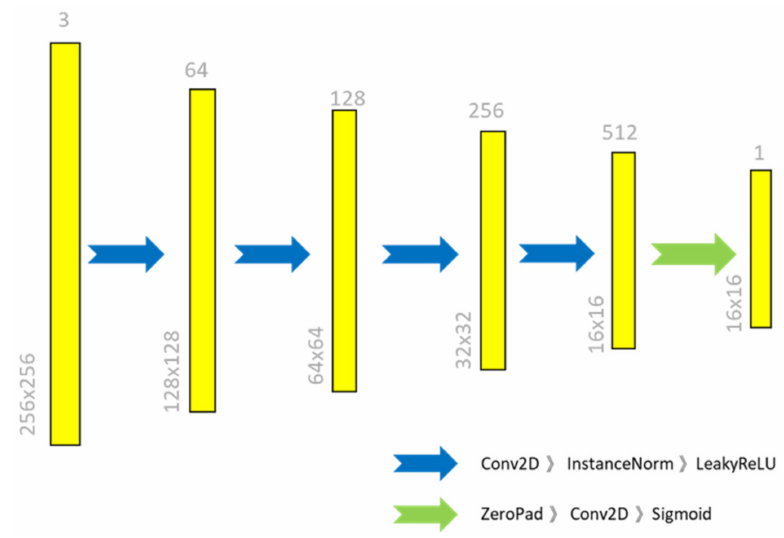
Figure 4. The discriminator architecture in the proposed